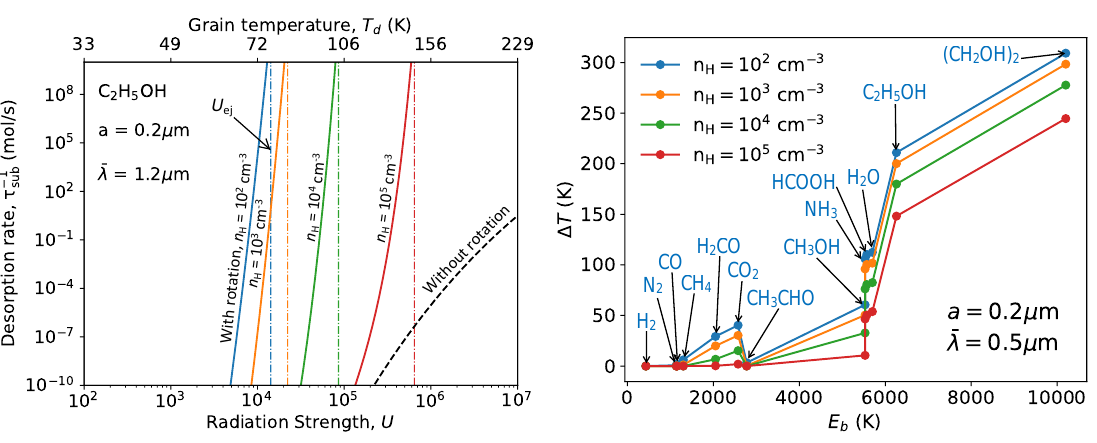
Figure 10. Left panel: ro-thermal desorption rate of molecules from a thin ice mantle compared to the classical sublimation time. Right panel: decrease of the grain temperature required for desorption at the same rate as classical sublimation. From Hoang and Tung